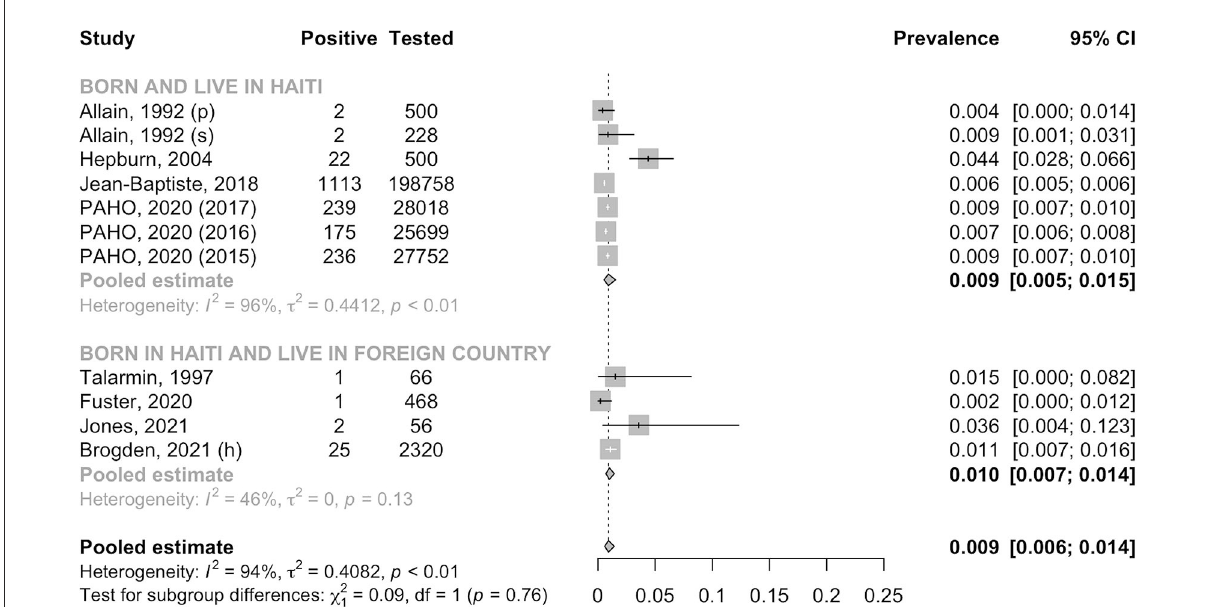
FIGURE8 Prevalence of anti-HCV antibody in the general adult population by place of residence. h, hospital recruitment; p, pregnant women; PAHO, Pan American Health Organization; s, surgery patient.